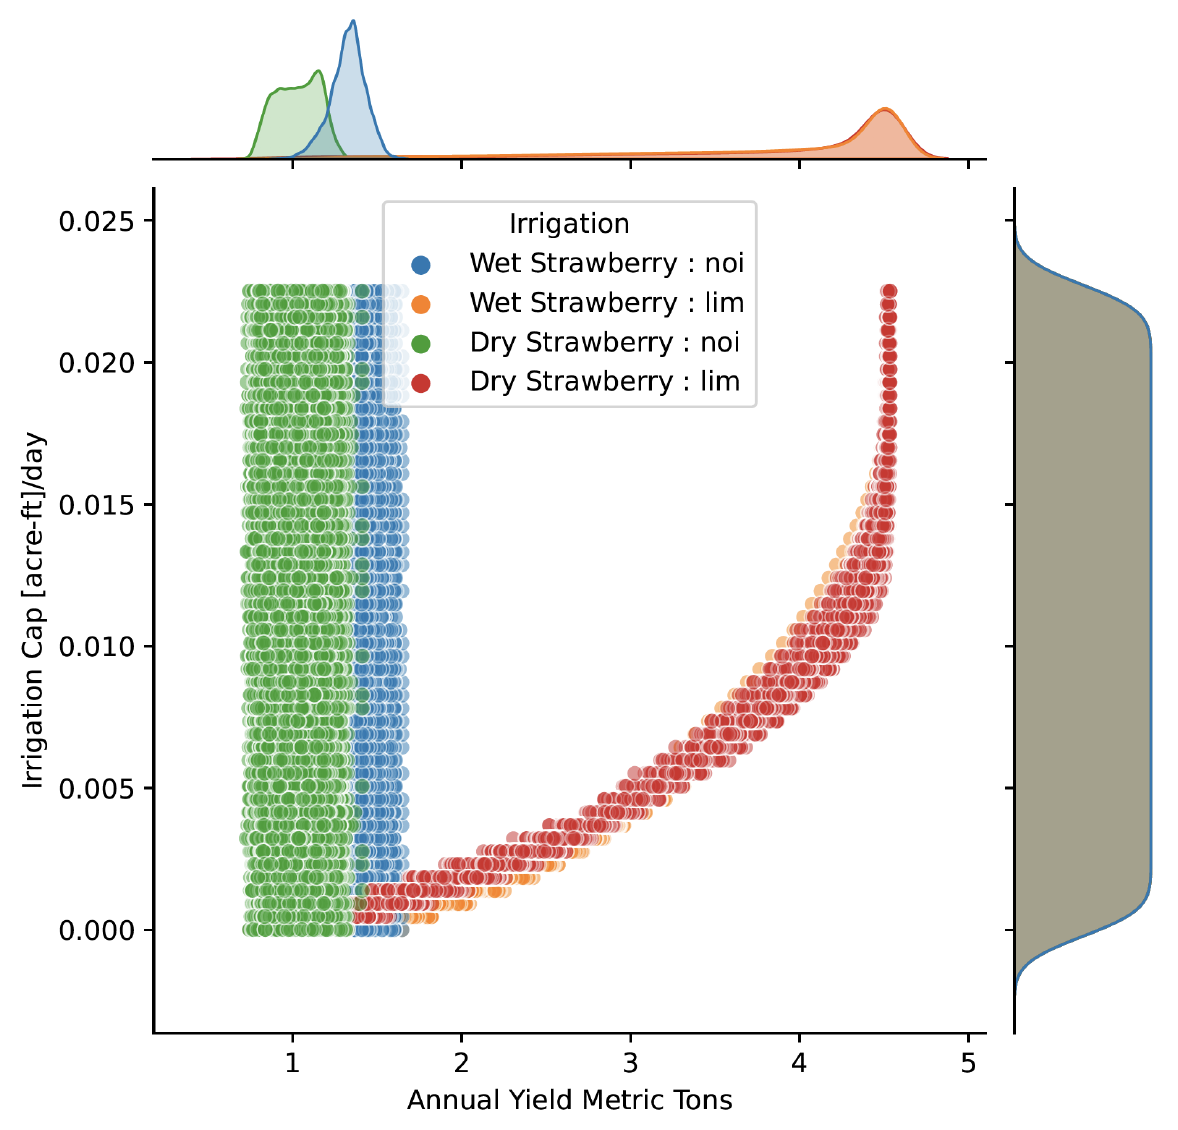
Figure 10: Sampled values of strawberry yield with water caps drawn from uniform distribution (on the right) and wet and dry forecasts (on the top). An irrigation cap 0f 0.015 acre-feet per day seems to be a threshold value.